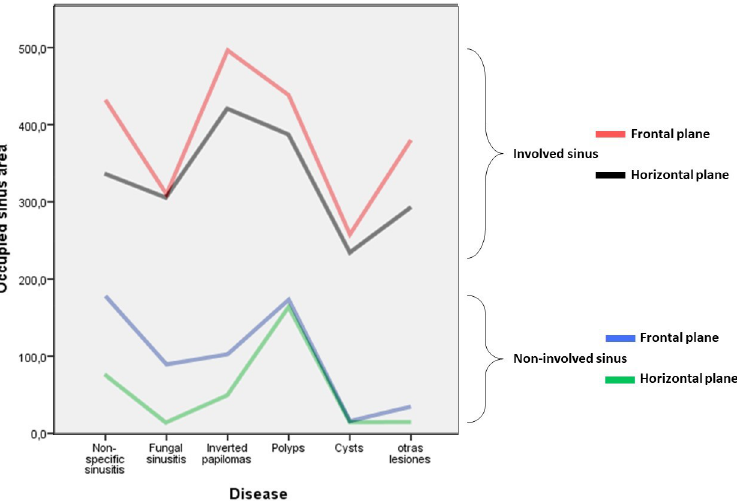
Fig 2. Area occupation. Diagram representing the average area of occupation in affected and healthy sinuses, measured in the horizontal or frontal plane, depending on the specific pathologies. In all of the pathologies, the occupation area was greater in the group of affected sinuses (p < 0.001).